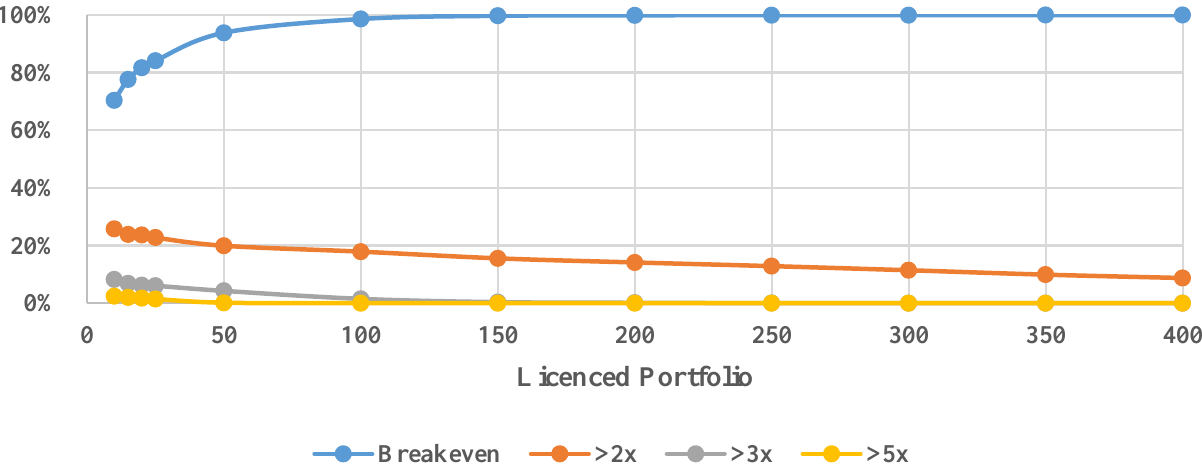
Figure 8. Impact of a lower quality portfolio: fewer power-law returns: 3.7 > 1.0%.